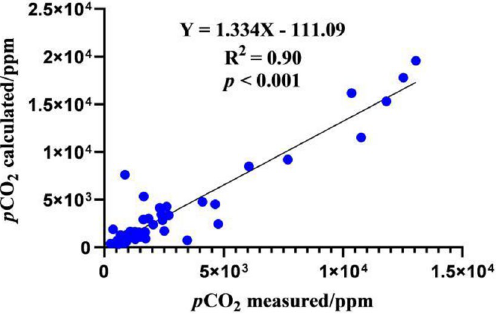
Figure 2. Comparison of the results of river p CO 2 at all sampling sites on the Xilin River by the measured and calculated methods.